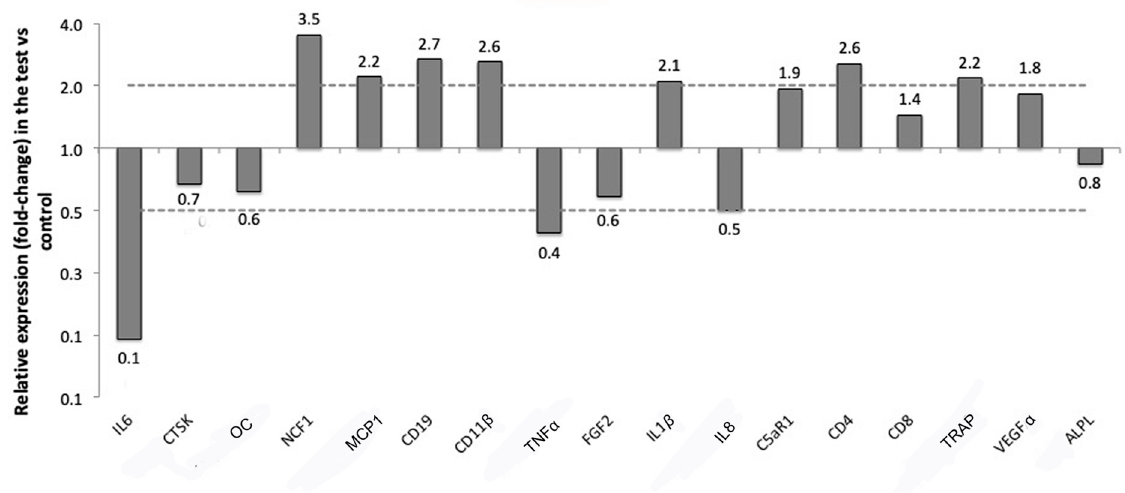
Figure 9. Up and down regulation of the selected markers in the bone around implants with silk ligatures versus controls (no ligature).